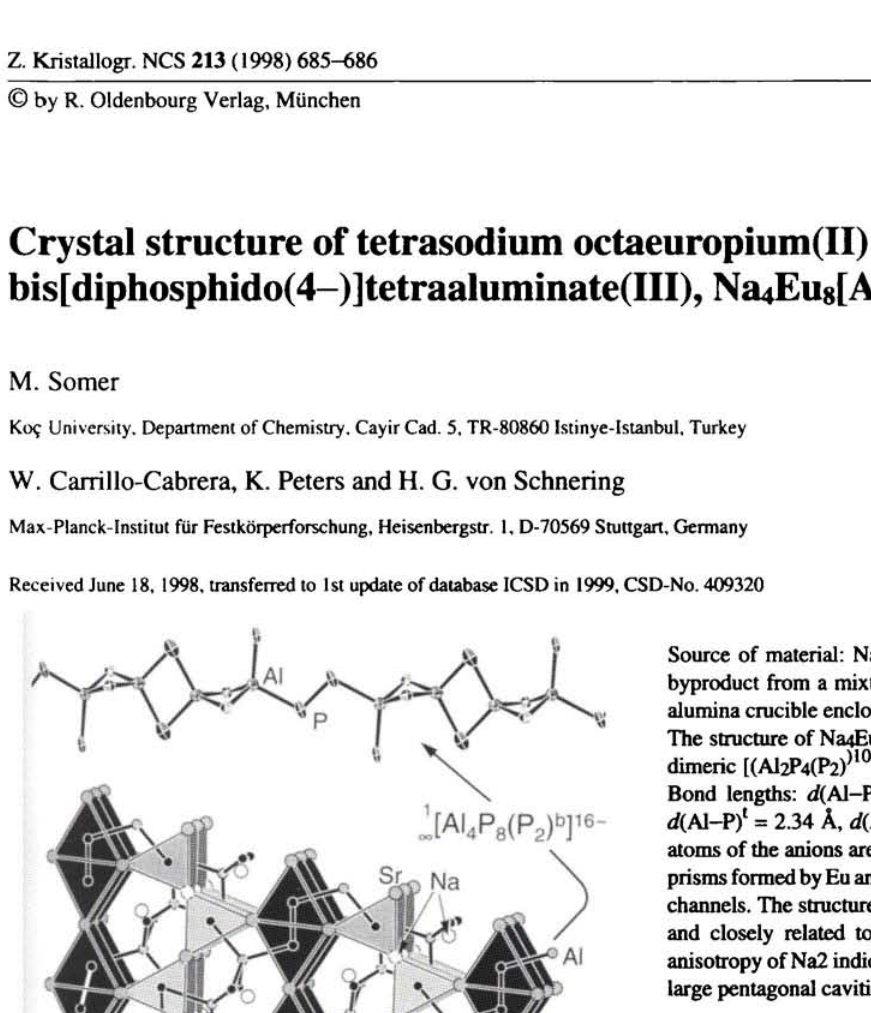
Table 1. Parameters used for the X-ray data collection Crystal: Diffractometer: